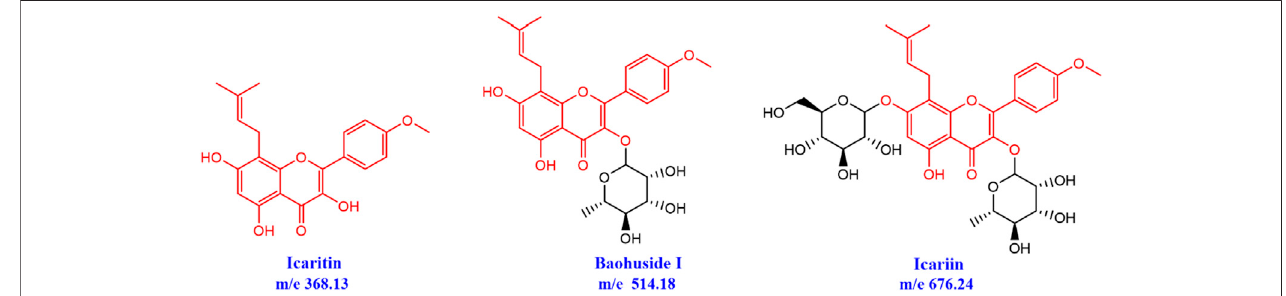
FIGURE 1 | Chemical structures of icaritin (IT), baohuside-I (BHG-I), and icariin